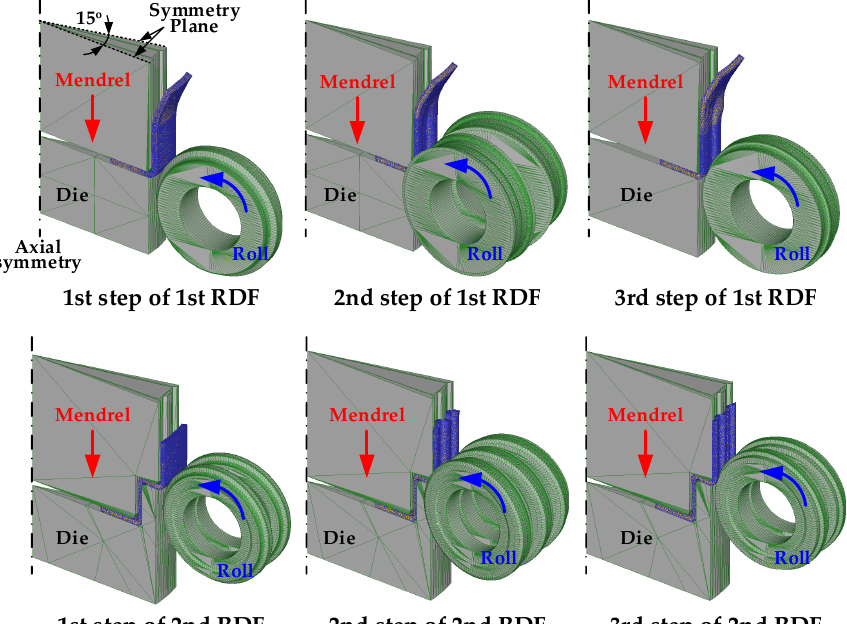
Figure 4. FE model for RDF